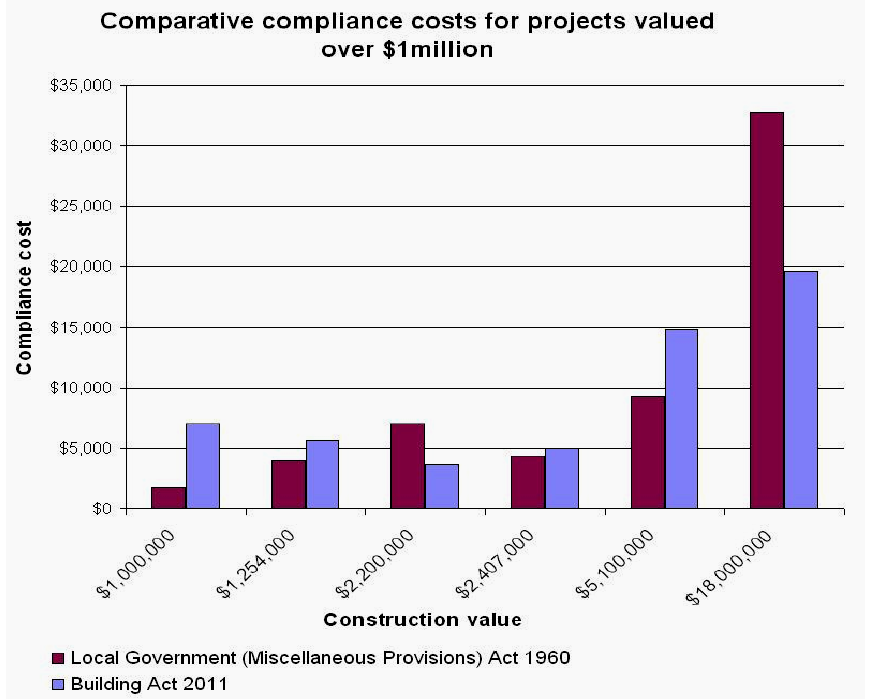
Figure 2 Comparative compliance costs under the Local Government (Miscellaneous Provisions) Act 1960 and the Building Act 2011, for 6 projects with construction values over $1